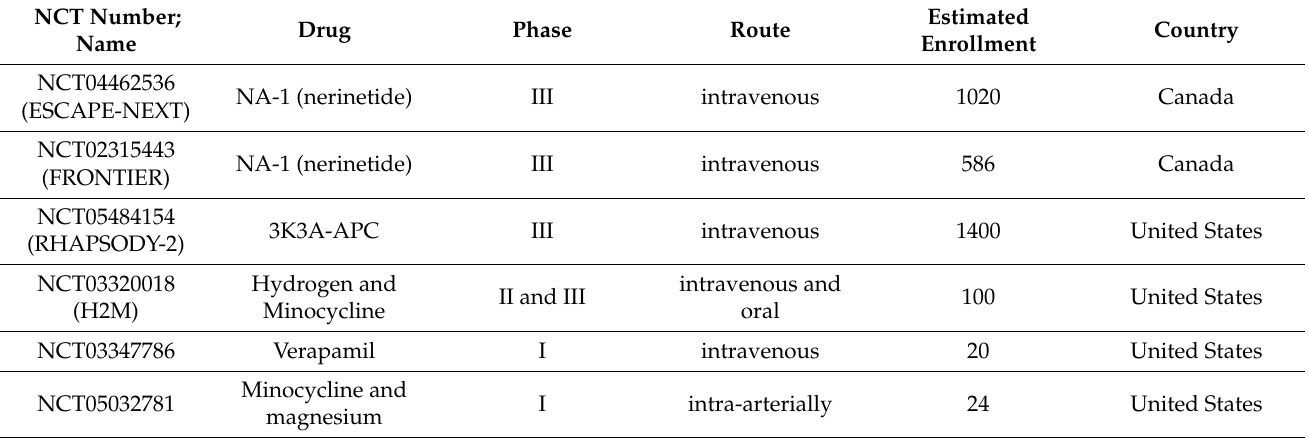
Table 2. Ongoing clinical trials investigating neuroprotective agents in ischemic stroke